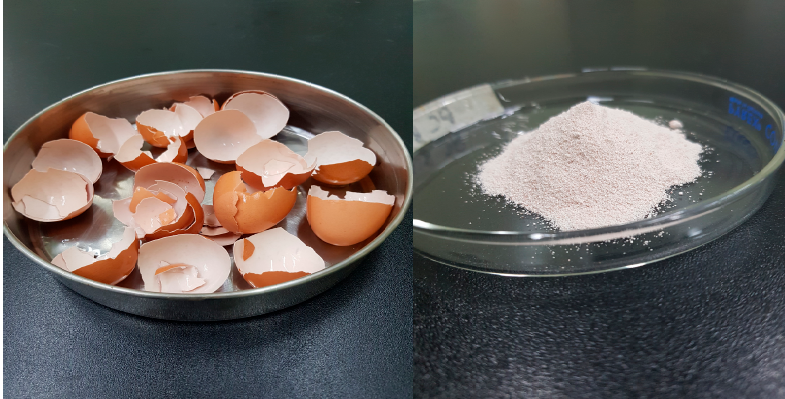
Table 1. Chemical composition of Portland cement and eggshell.